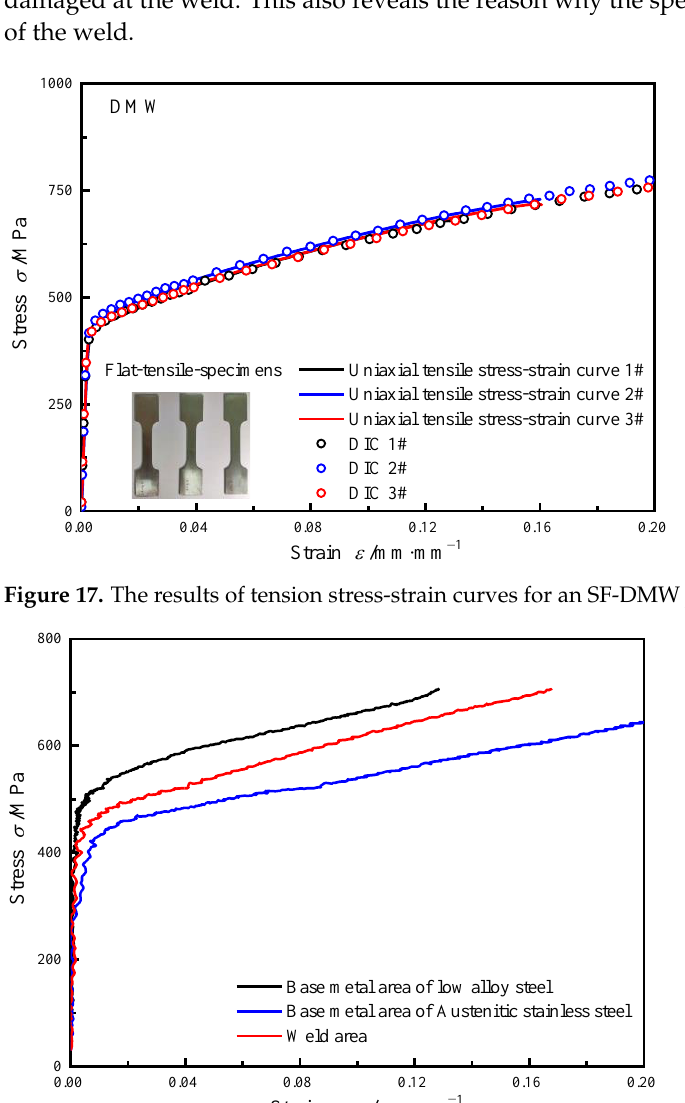
Figure 16. Strain variation curves in the width direction at the middle of the weld.